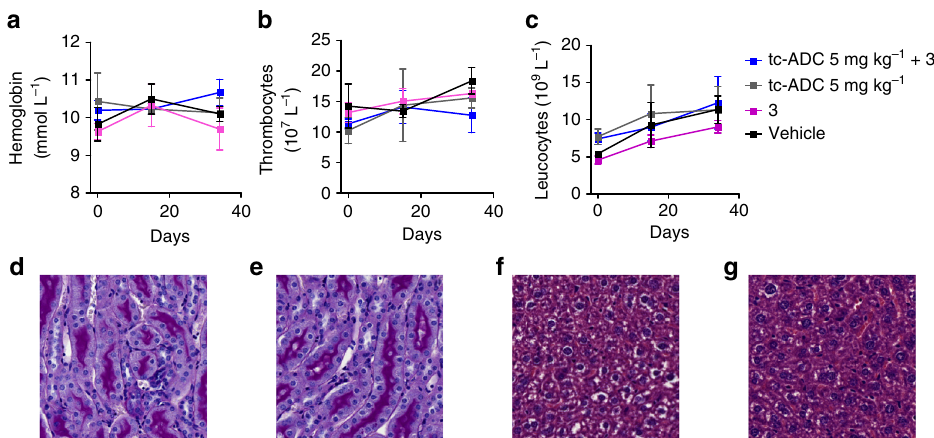
Fig. 7 Haematologic toxicity and histopathology evaluation. Haematologic toxicity assessment showing similar a haemoglobin, b thrombocytes and c leucocytes values in tumour-free mice that within 2 weeks received i.v. four cycles of the combination of tc-ADC (5 mg kg − 1 ) and activator 3 (48 h post- ADC; 0.335 mmolkg − 1 ), the ADC alone, 3 alone or vehicle; data represent the mean with s.d. ( n = 3). Histopathology: representative slices of renal cortex ( d , e ) and liver ( f , g ) obtained from tumour-free mice administered i.v. with four cycles of the combination of tc-ADC (5 mg kg − 1 ) and 3 (48 h